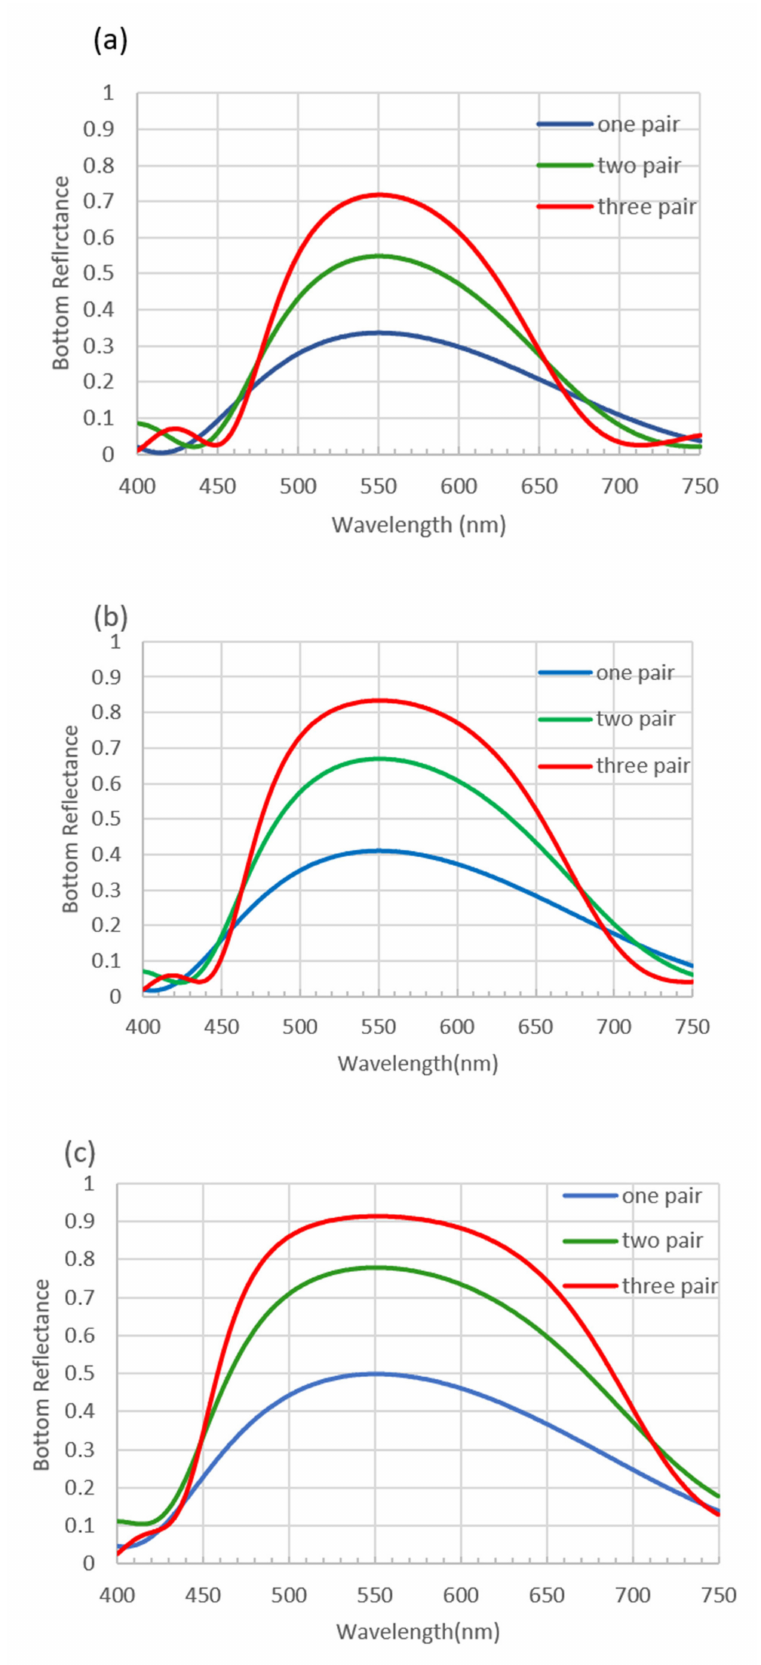
Figure 6. Reflectance spectra by the number of pairs for devices based on ( a ) DBR1 ( b ) DBR2 ( c )